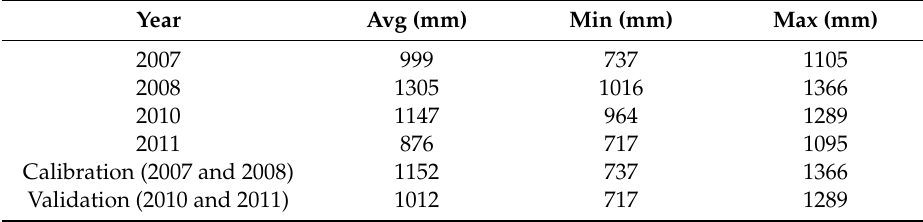
Table 5. Statistics for the Climate Forecast System Reanalysis (CFSR) precipitation data used in SWAT. Because there was some variation in total monthly precipitation for the 58 watersheds used in this study, the values reported are an average of all watersheds during each stated time